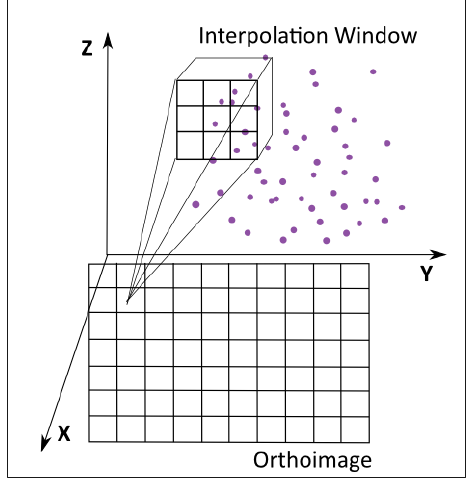
Figure 6: Interpolation method for 3D scattered points When no points are found within the window’s extent a black pixel is created, resulting in “holes” in the orthophoto. In order to improve the radiometric quality of the image an algorithmic function for hole filling is used, as proposed by Natsis (2008). This function detects the black pixels and interpolates their colour based on their neighbourhood (Fig.7). Figure 7: Hole filling method. Left : Original orthophoto with black pixels. Right : After the implementation of the hole filling